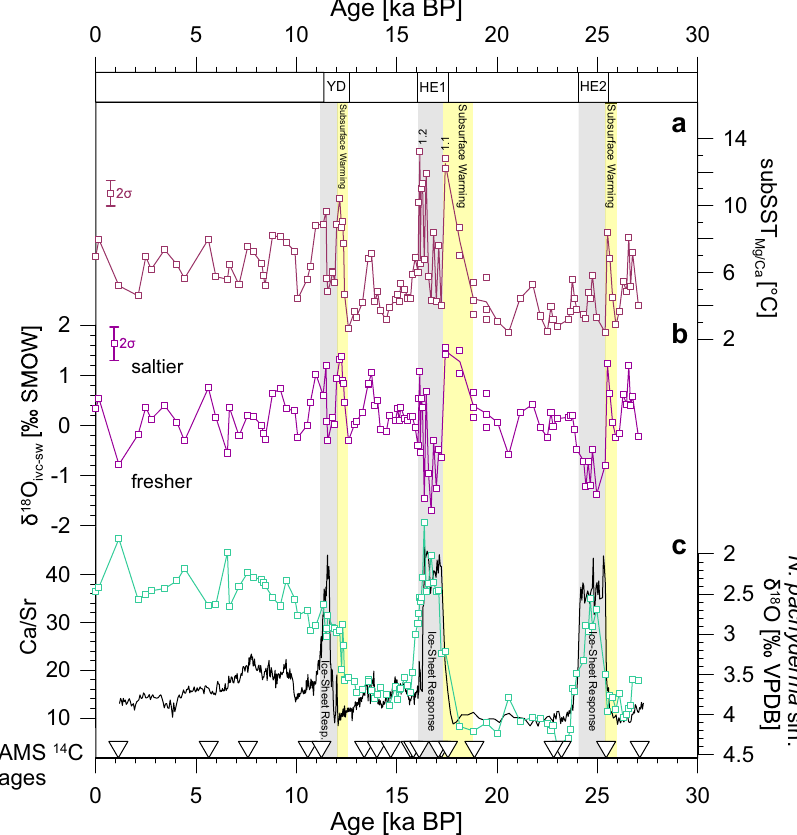
Fig. 3 Subsurface ocean variability and Heinrich Events over the last 27,000 years from sediment core GeoB18530-1. a Subsurface temperatures (subSST Mg/Ca ) with analytical uncertainty (2 σ ). b Ice-volume-corrected oxygen isotopic composition of seawater ( δ 18 O ivc-sw ) with analytical uncertainty (2 σ ). c Oxygen isotope composition ( δ 18 O) of Neogloboquadrina pachyderma sinistral and X-ray fl uorescence scanning-derived element ratio of calcium to strontium (Ca/Sr). Bottom: Open triangles indicate calibrated radiocarbon ages (AMS 14 C ages). yellow bars = phases of increases in subSST Mg/Ca into Heinrich Events and the Younger Dryas (YD); grey bars = Heinrich Layers (HE2 Heinrich Event 2, HE1 Heinrich Event 1 with Heinrich Event 1.1 and Heinrich Event 1.2 indicated) 21 and